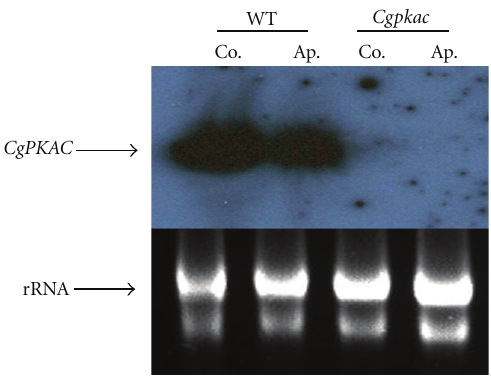
Figure 4: Northern blot analysis of total RNA obtained from conidia (Co.) and appressoria (Ap.) of the wild type (WT) and Cgpkac mutant ( Cgpkac ). The RNA was hybridized with 2.5kb CgPKAC .